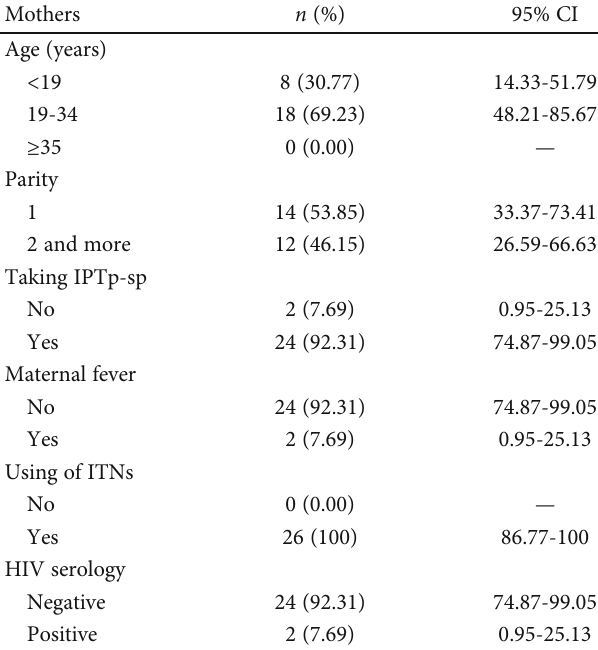
Table 2: Pro fi le of mothers of newborns who have contracted congenital malaria ( N = 26 ).